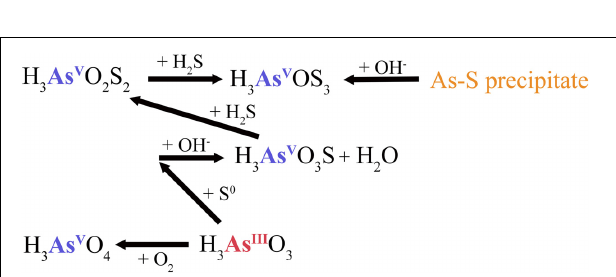
FIGURE 7 | Elemental sulfur-dependent arsenic cycle and dissolution of arsenic-sulfide precipitate at Artist’s Palette (AP). H 3 AsO 3 S, monothioarsenate; H 3 AsO 2 S 2 , dithioarsenate; H 3 AsOS 3 ,